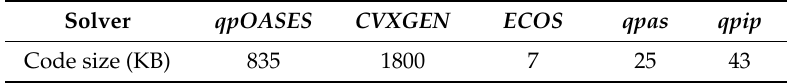
Table 3. Solvers’ storage requirements for the examined problem characteristics.